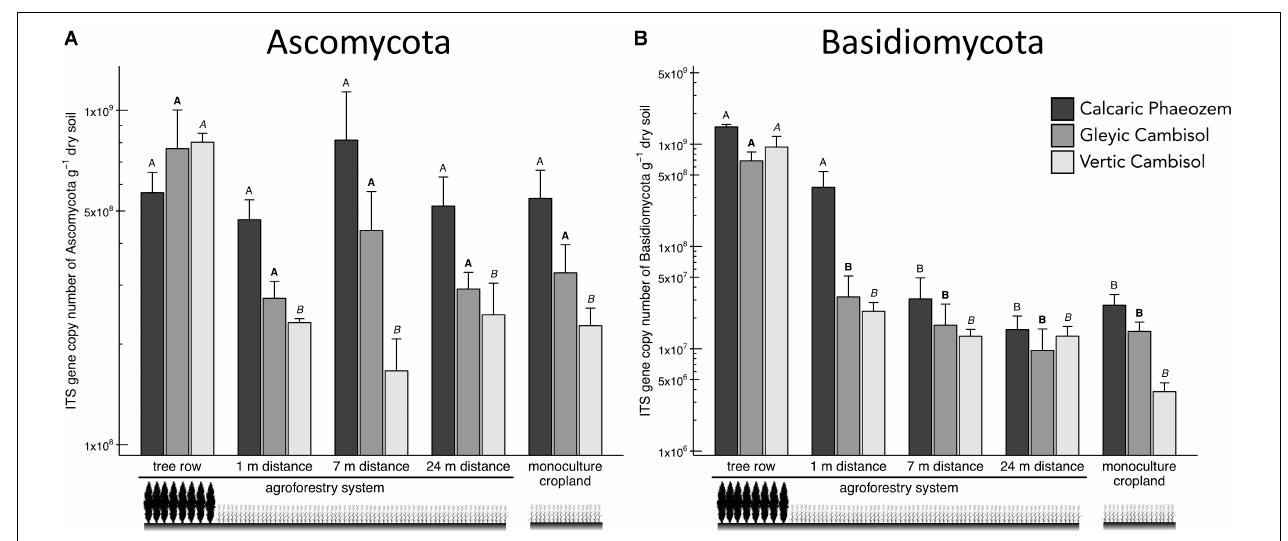
FIGURE 4 | Internal transcribed spacer (ITS) gene abundance of fungal groups [ (A) Ascomycota and (B) Basidiomycota] in soils of three paired temperate agroforestry and monoculture cropland systems. Means (bars are standard errors; n = 4) with different uppercase letters of the same font indicate statistically significant differences among the sampling locations (the tree row, 1, 7, and 24 m within the crop row of the agroforestry and the monoculture croplands) within one soil type (one-way ANOVA with Tukey’s HSD test of log 10 -transformed data at p <